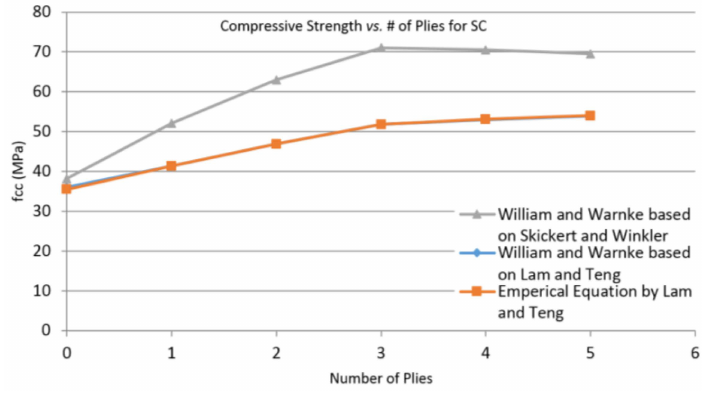
Figure 11. Updated compressive strength vs. number of plies for specimen SC.